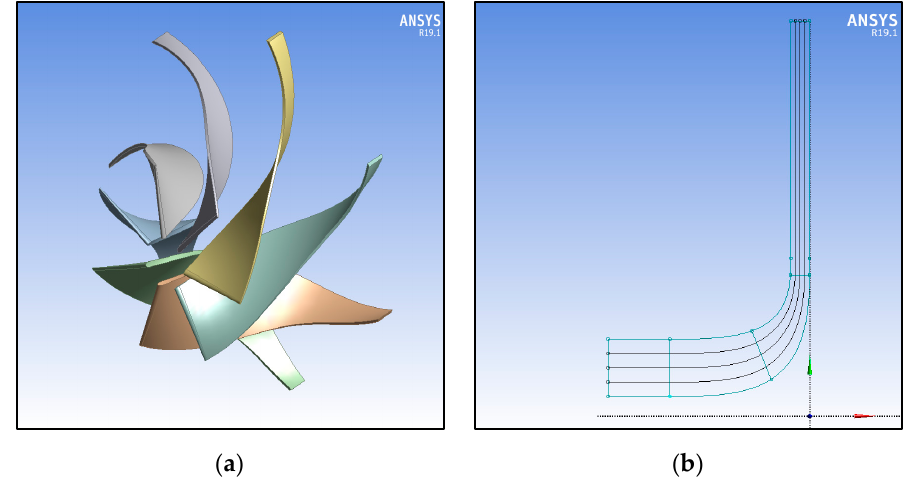
Figure 1. Impeller Blade Design ( a ) and Meridional Plane View ( b ).